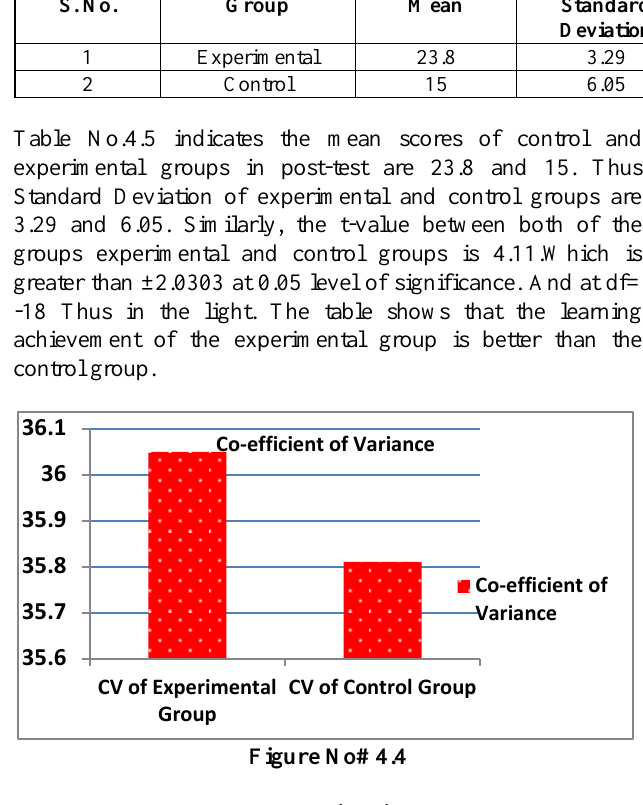
Table No 4.5: Mean Standard Deviation and t-value of Experimental and control groups on Post-test. S. No.